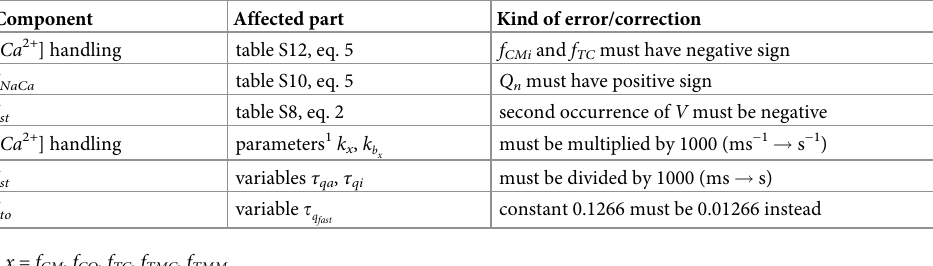
handling, which all have the unit ms − 1 in [54] but need to be multiplied by 1000 since [7] uses seconds as unit of time. As a second type of errors, there are inconsistencies between parameter values in the article and in the C++ and CellML implementations, which can be found in Table 3. Some of them, , seem to be undocumented changes that do have a large qualitative like the value used for P rel effect on simulations. Others, like the value of 22 7 700 instead of 22 2 700 for k , seem to be f TMC simple typing errors and oversights. Of these, it is notable that in the CellML model, the value of C is switched between the NH and the N cell model, which should have stood out if the m model was verified in simulations. These inconsistencies are even more pronounced in the initial values. Due to the large number of initial values to keep track of, we do not show them here but only in Tables 1–3 in S1 Text. It seems as though the initial states were chosen to resemble the near-steady state achieved right before a pulse during a long-term simulation with a current pulse protocol. However, this information is missing in the article. We only found this pattern through trial and error and by a hint in the version history of the CellML model. Even with this knowledge, still large inconsistencies remain between the article, the C++ model, and the CellML model with some open questions. For example, we suspect that there is an order of magnitude error in the reported initial value for the parameter f in the N cell model in the article. While these TC errors do affect simulations for up to 20 seconds, all variables that need an initial value do